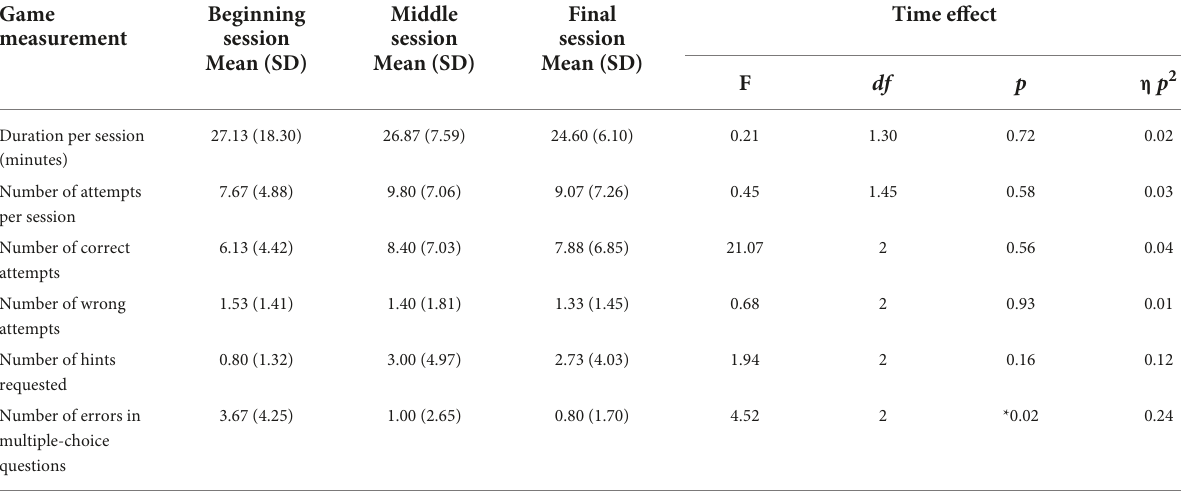
TABLE 2 Repeated measures for mean scores on augmented reality game performance at beginning, middle, and final sessions.